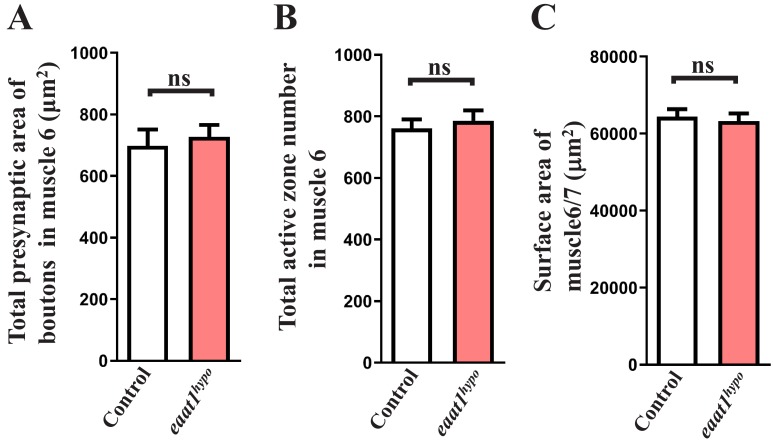
Morphological analysis of eaat1hypo mutant NMJ boutons and muscles.(A,B) Quantification data for the total presynaptic area of NMJ boutons and total number of active zones in A2 muscle 6 of third instar larvae from controls (w1118) and eaat1hypo/hypo mutants (n ≥ 8 NMJs derived from n ≥ 5 animals for each genotype). Active zones were marked by α-Brp (nc82) immunostaining. (C) Quantification data for A2 muscle 6 and 7 surface area (n = 36). P value: ns, no significance. n: replicate number. Error bars indicate SEM. Statistics: Student's t-test.10.7554/eLife.47372.006Figure 1—figure supplement 2—source data 1.Source data for Figure 1—figure supplement 2.